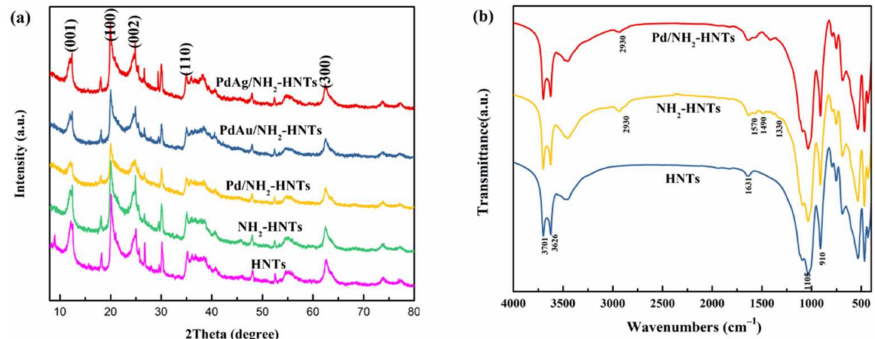
Figure 2. ( a ) XRD patterns; ( b ) FTIR